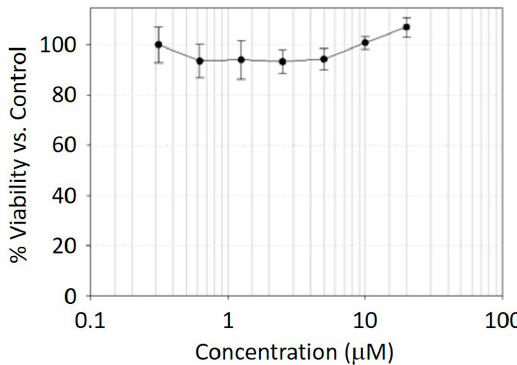
Figure 4. MTT cell viability tests with different concentrations of Cy5-BF 3 ( 19 F) after 24 hour of incubation with A549 cells.